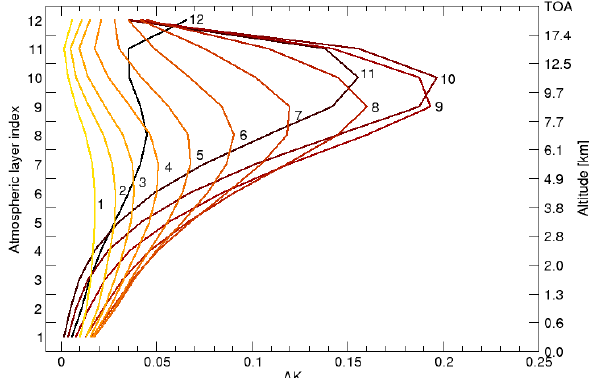
Figure 1. A typical averaging kernel for GOSAT-TIR daytime mea- surements over land. The colour coding is such that dark colours correspond to the averaging kernels at high altitudes and the bright colours to low altitudes. The numbers next to the curves refer to the corresponding atmospheric layer index as is indicated on the left side of the